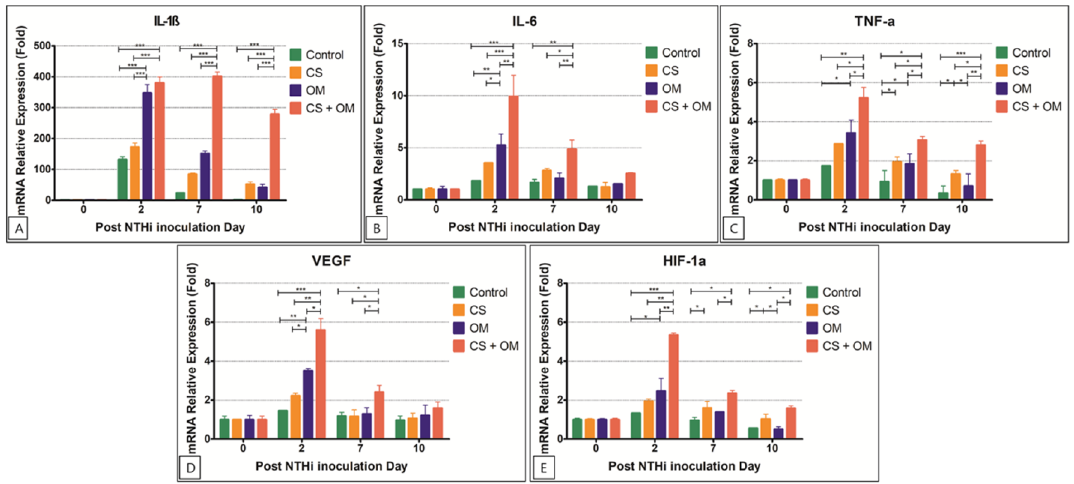
Figure 3. Expression of interleukin (IL)-1ß ( A ), IL-6 ( B ), tumor necrosis factor (TNF)-α ( C ), vascular endothelial growth factor (VEGF) ( D ), and hypoxia-inducible factor (HIF)-1α ( E ) in the middle ear mucosa at various time points after non-typeable Haemophilus influenzae (NTHi) inoculation.